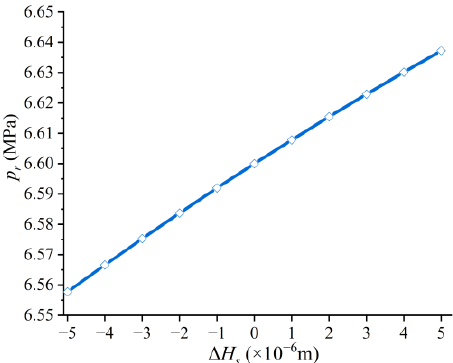
Figure 22. Installation error dependence of balance pressure.